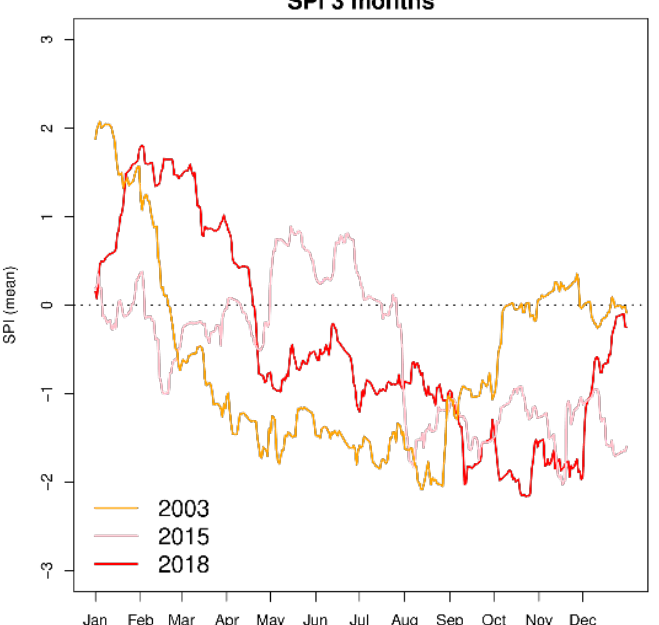
Figure 2. Seasonal evolution of daily standardized precipitation index (SPI, calculated for the three- month timescale), averaged over the considered grassland stations for the dry years of 2003, 2015, and 2018. SPI value of 0.99 to − 0.99 = normal, − 1.0 to − 1.49 = moderately dry, − 1.5 to − 1.99 = severely dry, and − 2.0 or less = extremely dry.